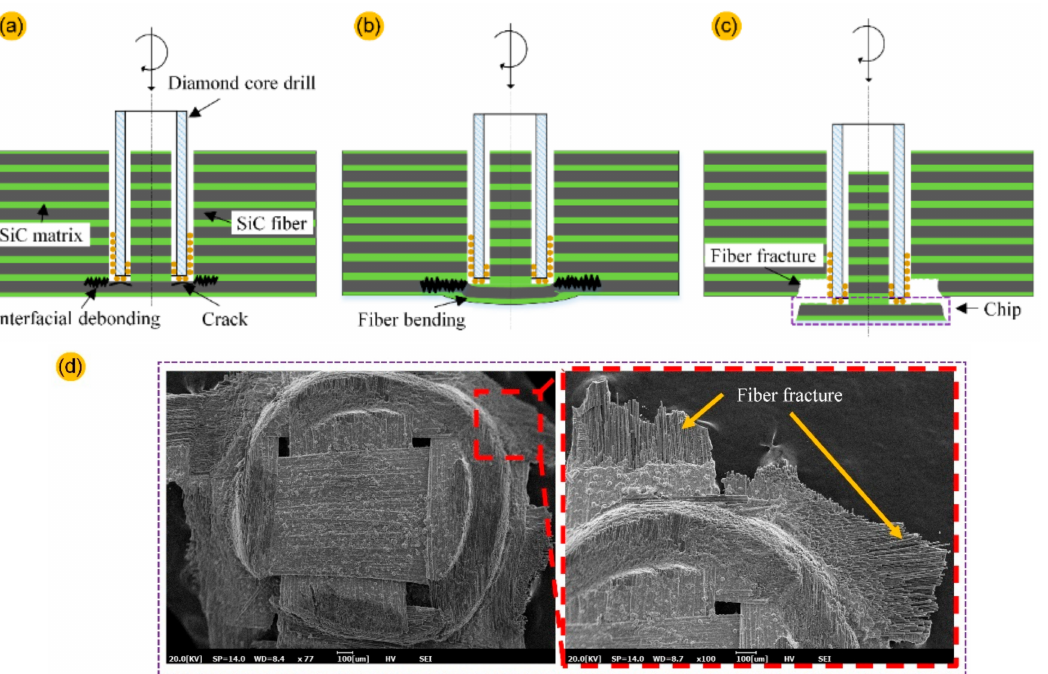
Figure 17. Hole exit tearing damage formation process, ( a ) fiber-matrix interface debonding, ( b ) fiber bending, ( c ) fiber breaking, and ( d ) chip morphology.